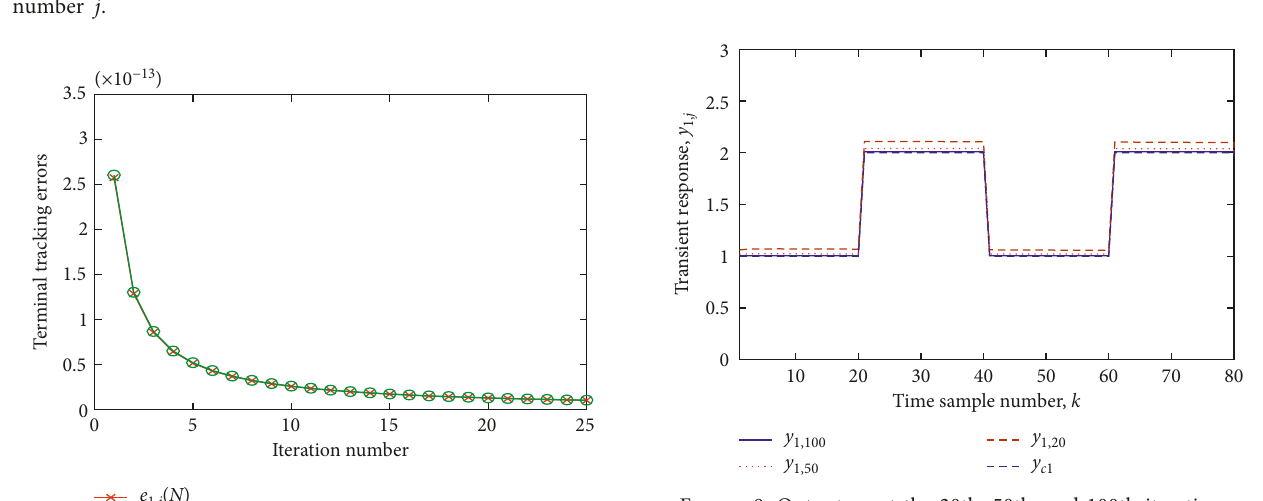
e 1 ,j and 2 ,j versus the iteration